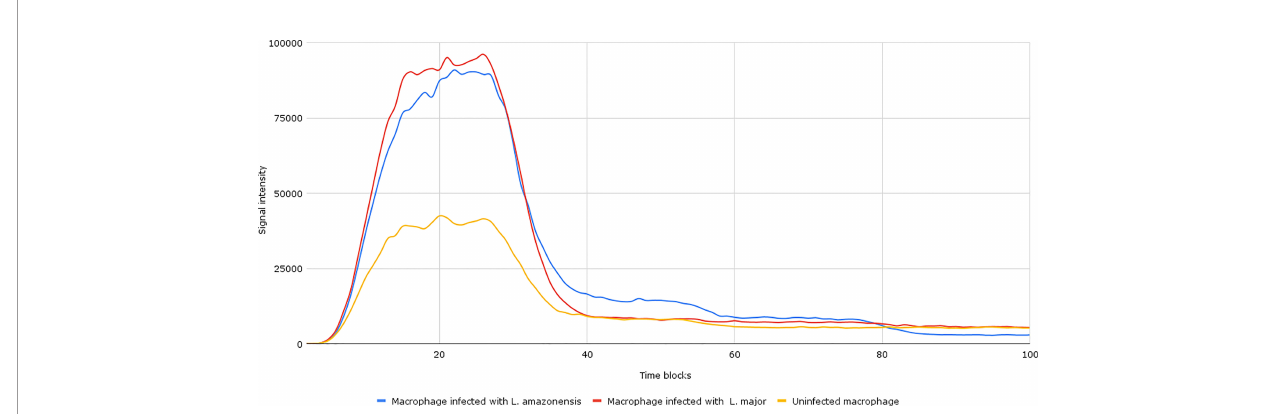
FIGURE 2 | Accumulation token result of the initial network simulation. Under normal conditions, as can be seen in the yellow lines (uninfected macrophages), the fi nal response signal intensity is about 2 – 3 times lower than when compared to samples of Leishmania major - and Leishmania amazonensis -infected macrophages (represented by the red and blue lines, respectively). To be generated, the initial information fl ow starts with the activation of transcription factors (input nodes). These factors interact with a set of genes (transmission node) through processes (mode of interaction). These processes are responsible for intensifying or reducing the intensity of the signal generated in response.